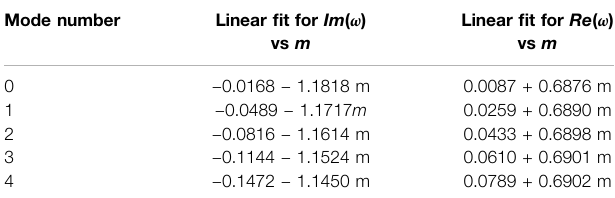
Linear fi t for Re ( ω ) vs m vs